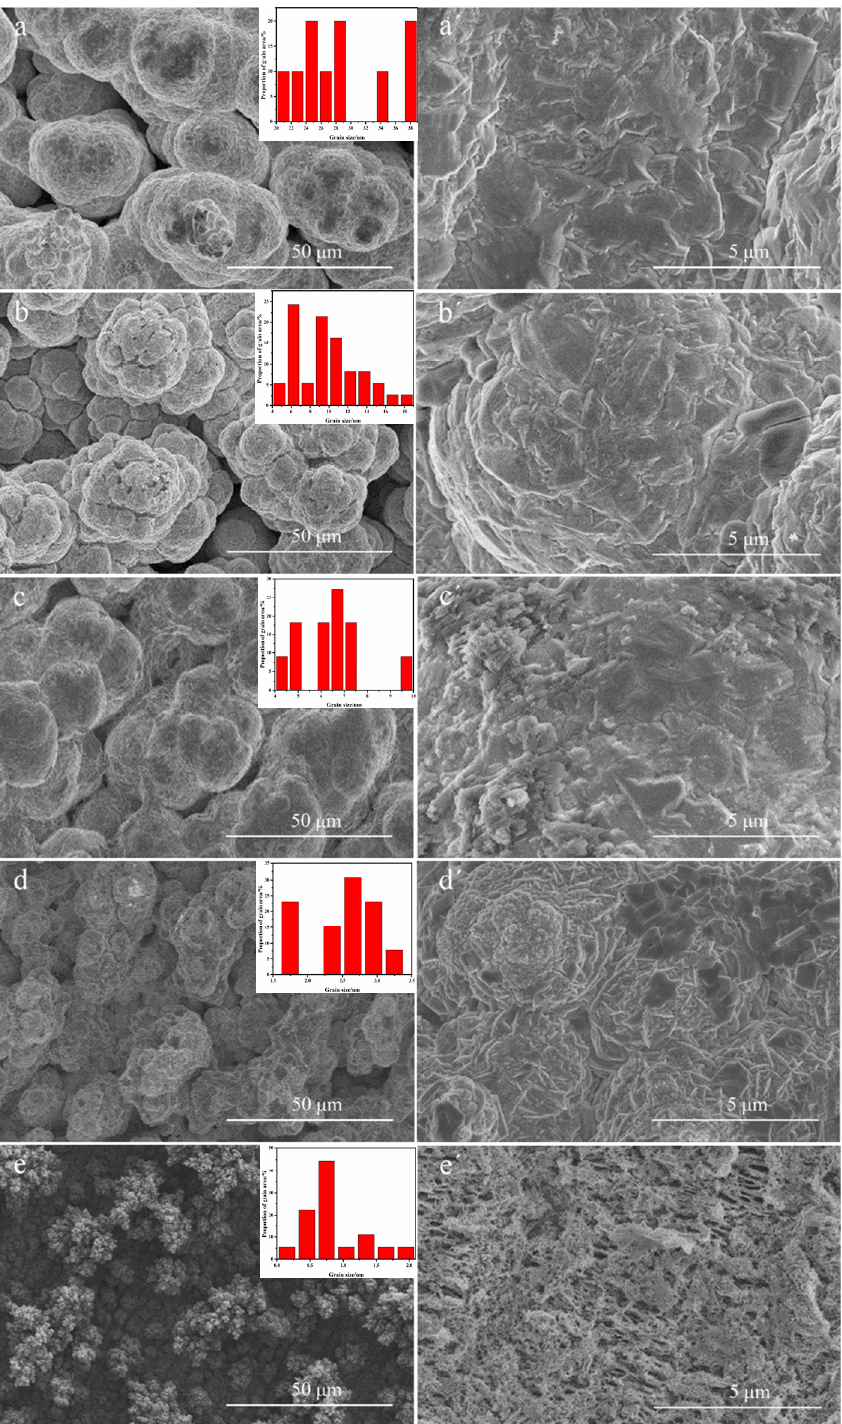
Figure 6. SEM images of Cu-Se film deposited at different potentials: ( a – e ) 0.065 V, 0.055 V, 0.040 V, 0.020 V, and 0.010 V, at 1000 magnification (Inserts: corresponding grain size distribution); and ( a (cid:48) – e (cid:48) ) 0.065 V, 0.055 V, 0.040 V, 0.020 V, and 0.010 V, at 10,000